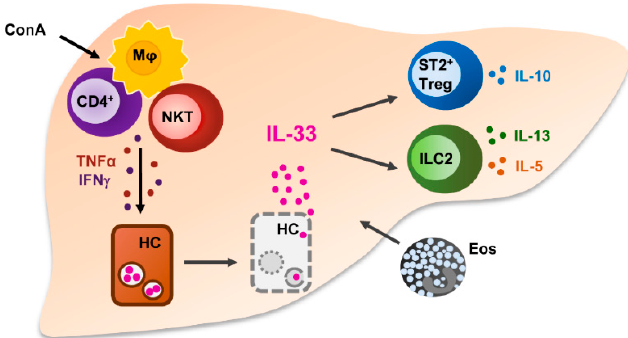
Figure 3. Immune regulatory function of IL-33 in ConA-induced hepatitis. In homeostasis, IL-33 is located in the nucleus of hepatocytes. During ConA-induced hepatitis, activated NKT cells, CD4 + T cells and macrophages produce the inflammatory cytokines TNF α and IFN γ subsequently leading to hepatocyte death by necrosis and release IL-33 in liver tissue. Extracellular IL-33 activates ILC2, which is associated with hepatic infiltration of inflammatory eosinophils. IL-33 also activates ST2 + Tregs that might exert immunosuppressive function in sterile liver inflammation. ConA: concanavalin A, M ϕ : macrophage, NKT: natural killer T cell, TNF α : tumor necrosis factor α , IFN γ : interferon γ , HC: hepatocyte, ST2: suppression of tumorigenicity 2, Treg: regulatory T cell, ILC2: type 2 innate lymphoid cells, Eos: eosinophils.